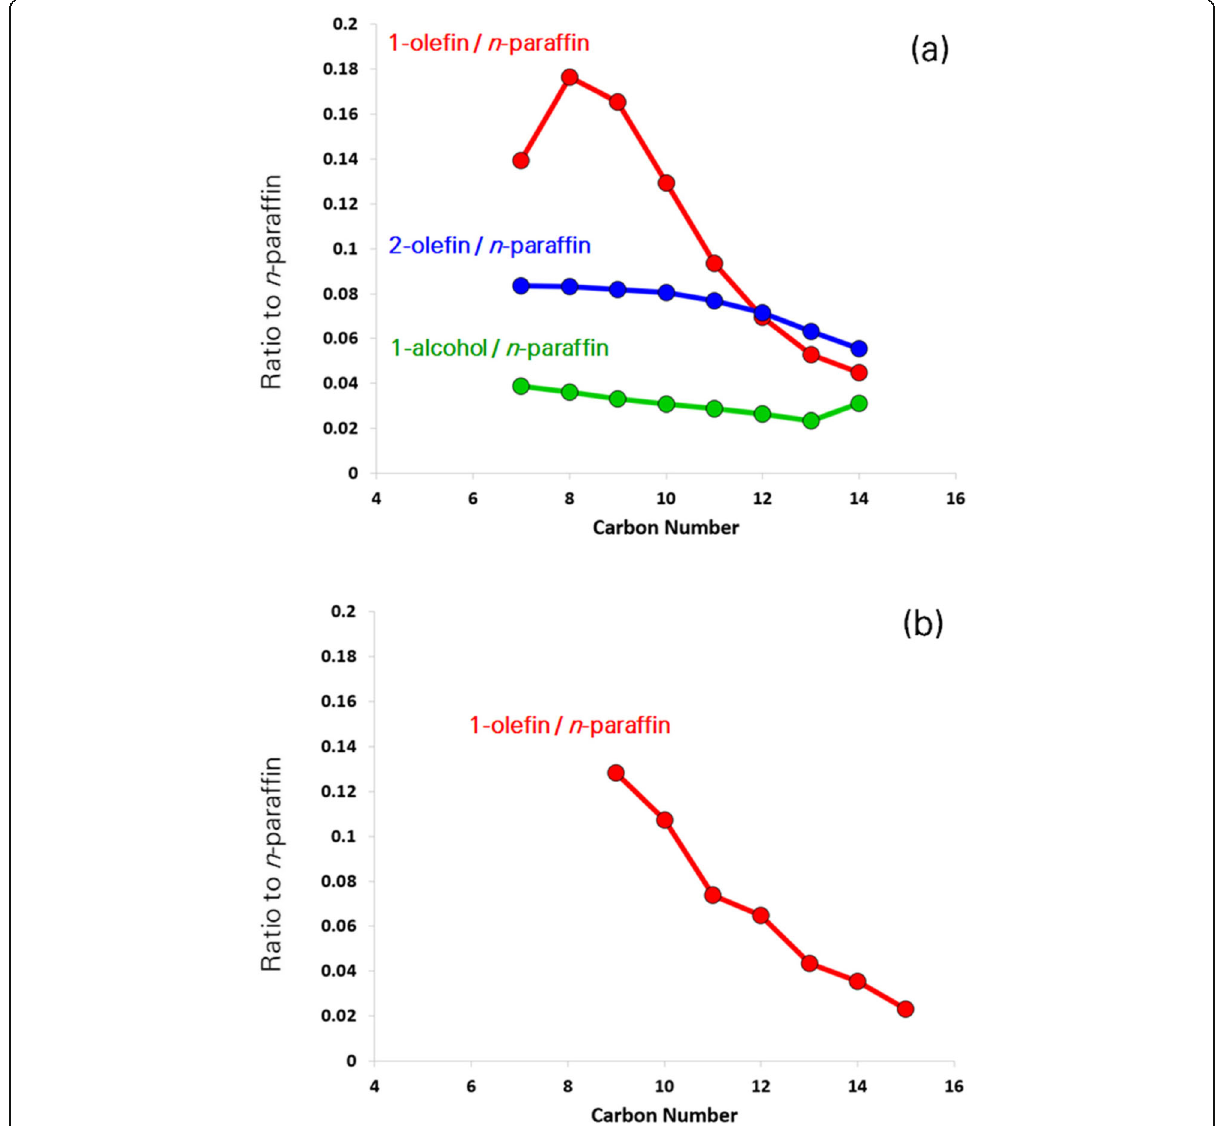
Fig. 4 Molar ratio of olefin and 1-alcohol to n -paraffin. a Molar ratio of olefins and 1-alcohol to n -paraffin in LHcL1 for C 7 – C 14 . b Molar ratio of